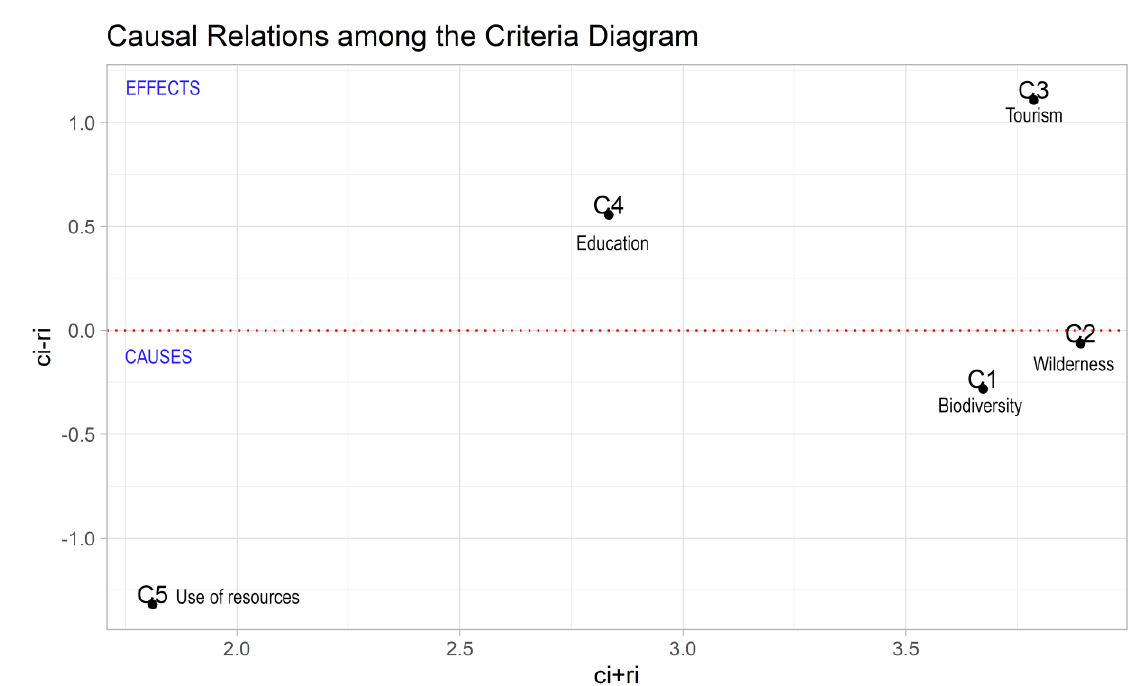
Figure 3. DEMATEL diagram of causal relations among criteria.